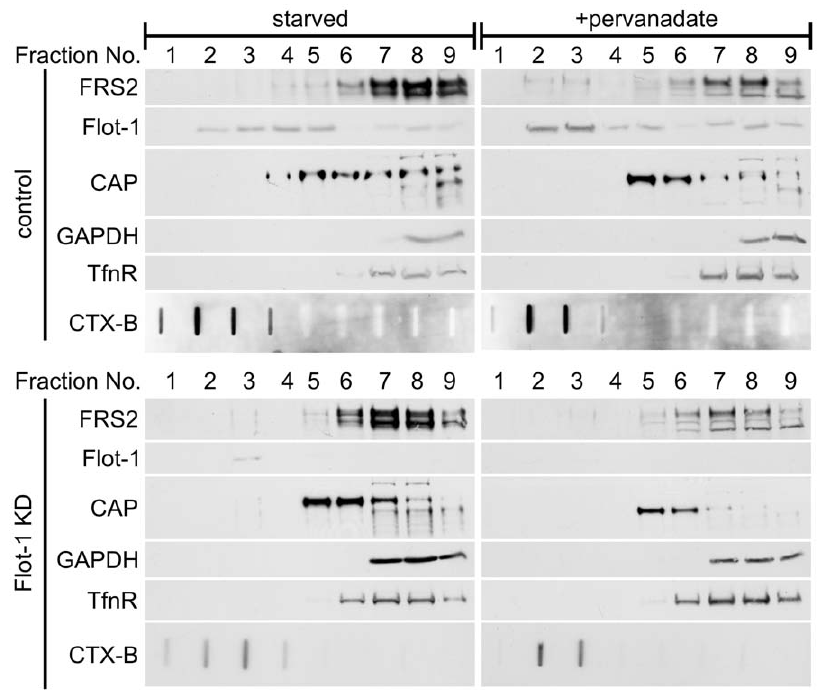
Figure 5. Flotillin-1 is required for the recruitment of FRS2 into light membranes in pervanadate treated cells. Hep3B cells (control: upper panels, flot-1 knockdown: lower panels) were starved overnight and then stimulated with pervanadate. Detergent resistant light membranes were prepared using density gradient centrifugation and found in fractions 1–3 of the gradient. The localization of FRS2, flot-1 and CAP was analyzed. Western blots for transferrin receptor (TfnR), GAPDH and GM1-bound cholera toxin subunit B (CTX-B) were used to control the gradient.